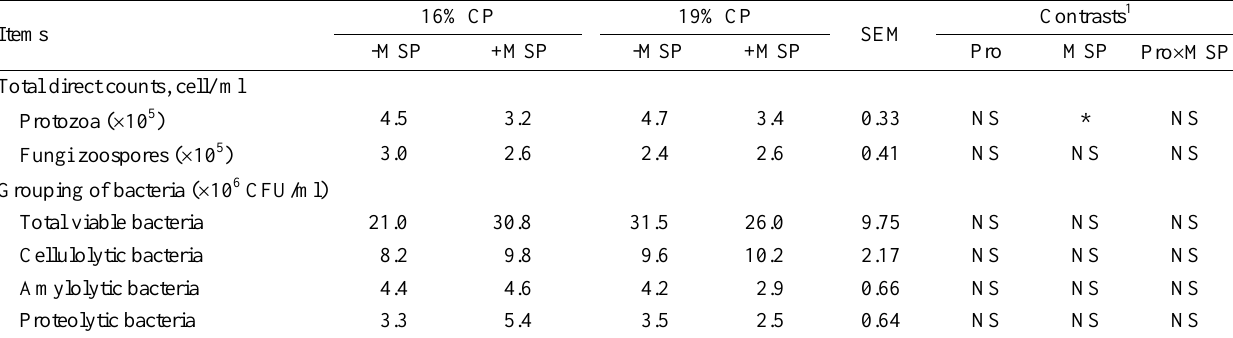
Table 4. Effect of protein level and mangosteen peel pellets (Mago-pel) in concentrate diet on microbial population in the rumen of lactating dairy crossbreds